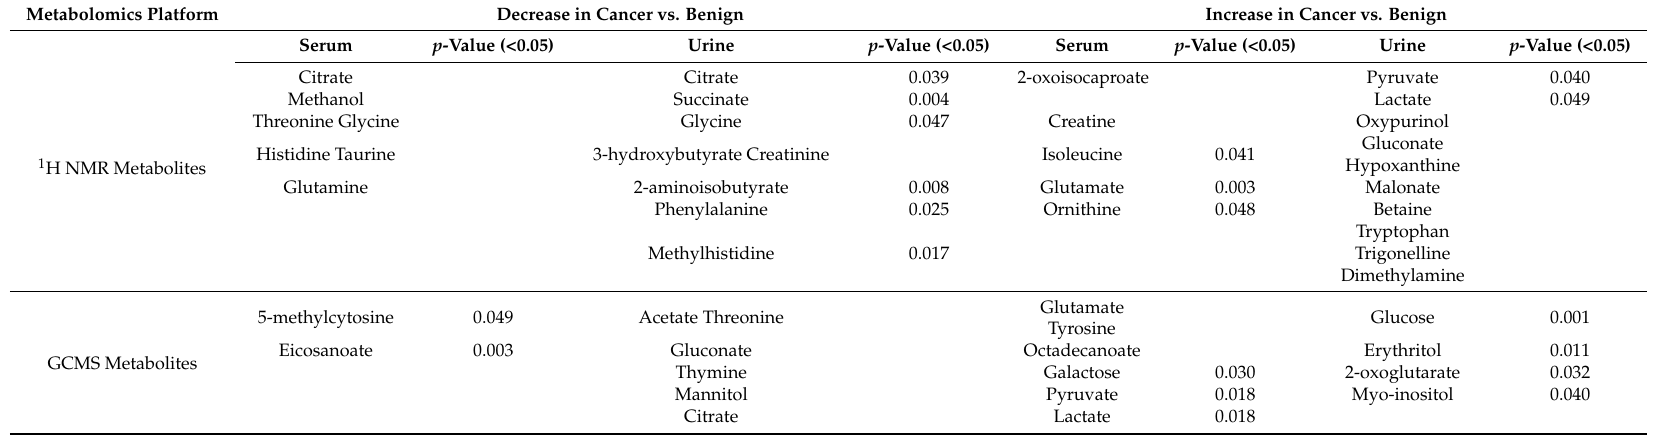
Table 3. Differential metabolites linked to cancer in 1 H NMR and GCMS analysis of serum and urine (significant metabolites are shown with p <